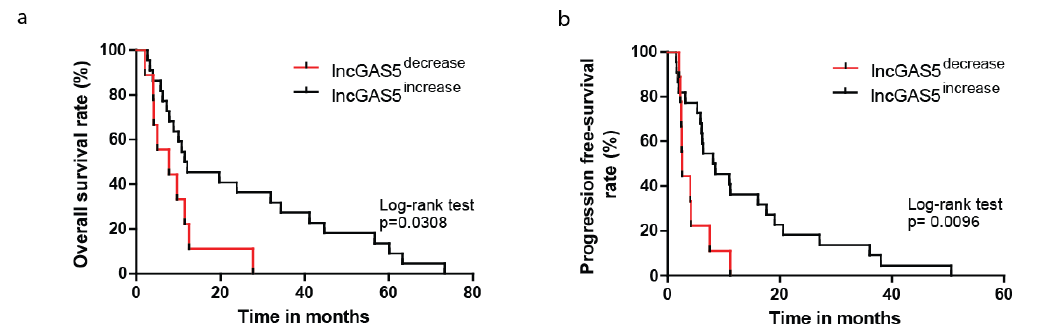
Figure 3. Decrease of circulating levels of GAS5 is associated with the worse patient outcome. Patients with decreased circulating GAS5 after chemotherapy had a shorter overall survival ( a ) and a shorter progression-free survival ( b ).